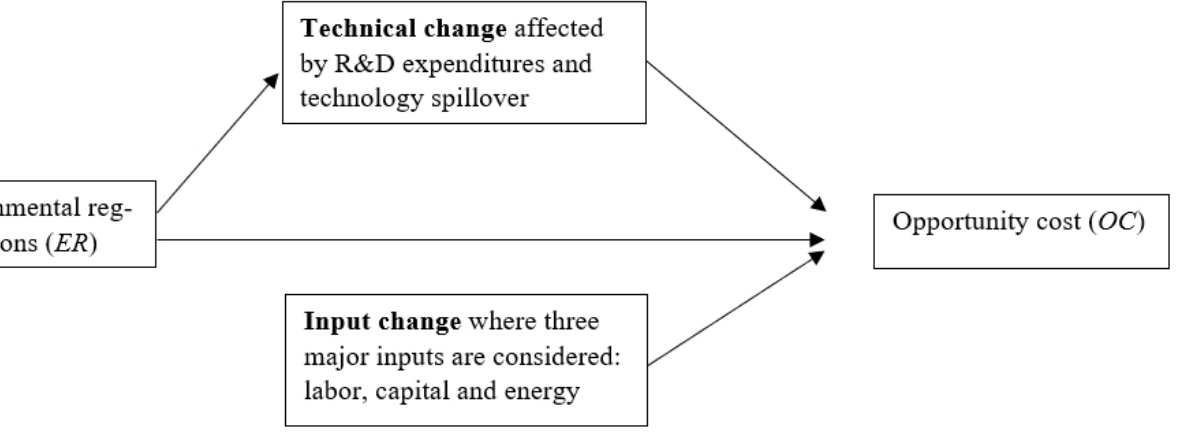
Figure 4. Mediation model of environmental regulations and opportunity cost.